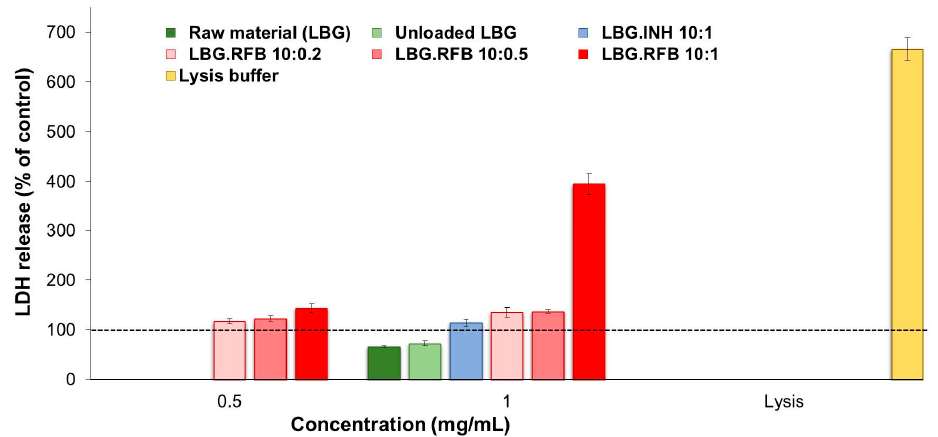
Figure 8. LDH released from A549 cells after 24 h exposure to LBG polymer, LBG microparticles and lysis buffer. Amount of LDH released from cells incubated with cell culture medium is assumed as 100% (dashed line). Results are expressed as mean ± SEM ( n = 3, six replicates per experiment at each concentration; INH: isoniazid; LBG: locust bean gum; RFB: rifabutin).